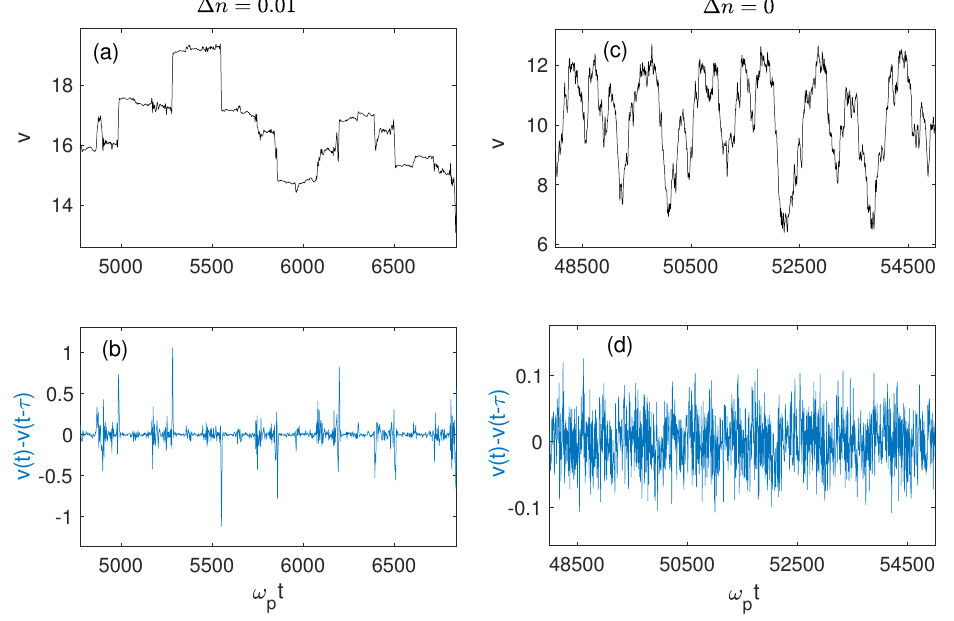
Figure 17. ( a , b ) Inhomogeneous plasma with ∆ n = 0.01: time variation of ( a ) the velocity v ( t ) and ( b ) the velocity variations δ v τ ( t ) = v ( t ) − v ( t − τ ) of a typical test particle. ( c , d ) Homogeneous plasma: time variation of ( c ) the velocity v ( t ) and ( d ) the velocity variations δ v τ ( t ) = v ( t ) − v ( t − τ ) of a typical test particle. Main parameters are: v b / v T = 12, n b / n 0 = 10 − 4 , τ = 20. Particle velocities are normalized by the plasma thermal velocity v T